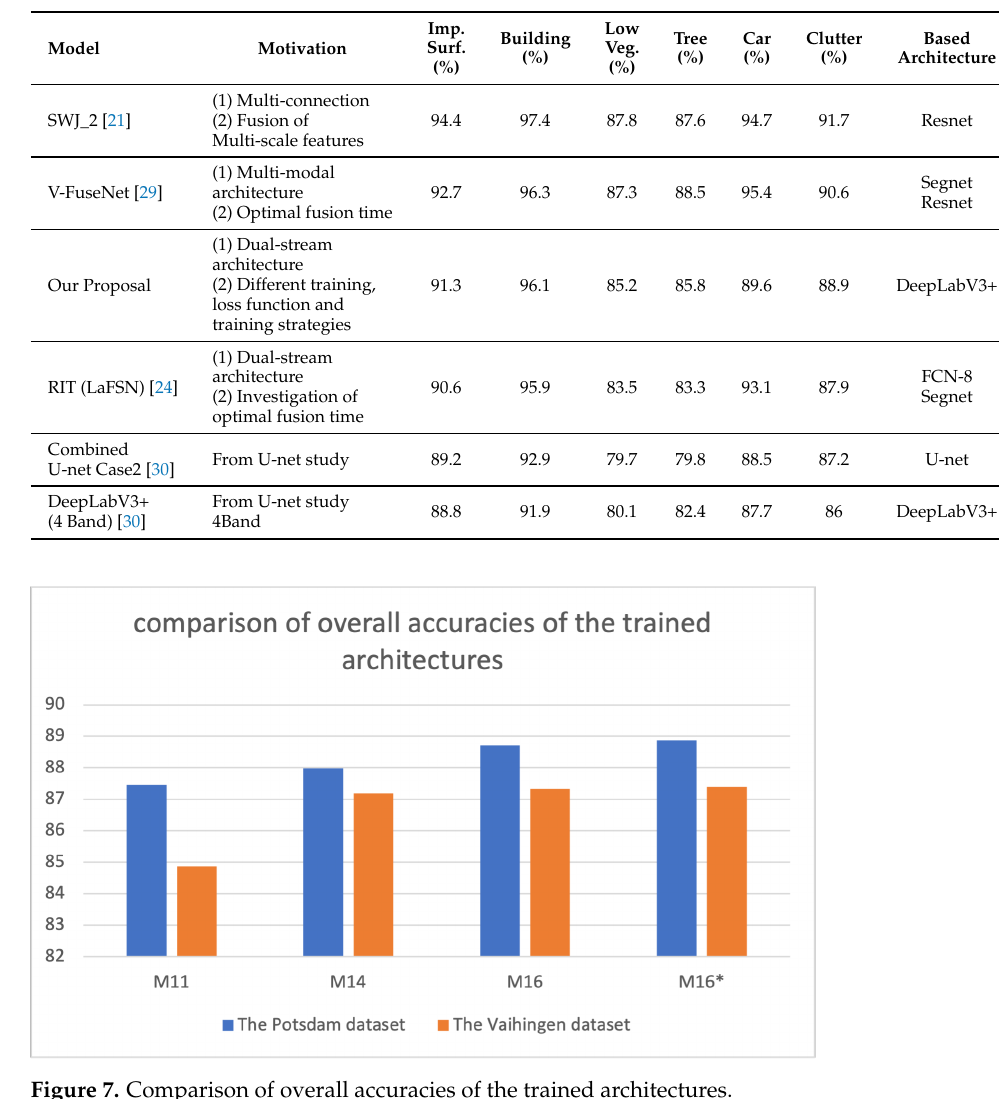
Table 11. Performance metrics of various methods for ISPRS Potsdam dataset.